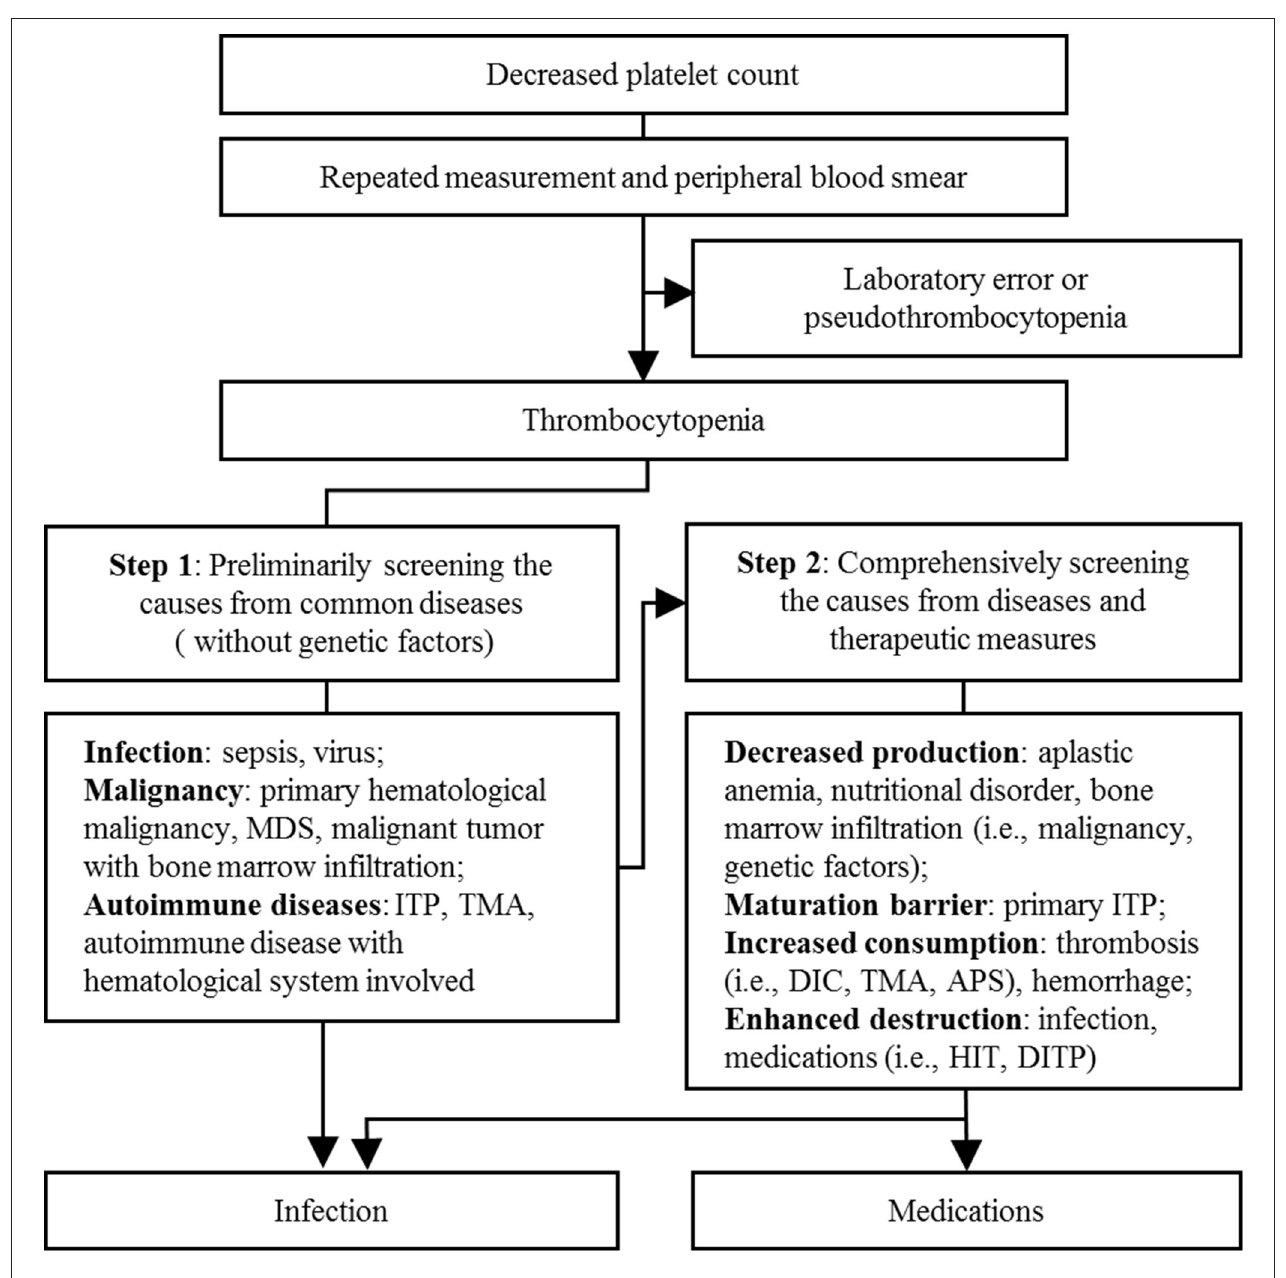
FIGURE 2 | Diagnostic reasoning in thrombocytopenia. APS, antiphospholipid syndrome; DIC, disseminated intravascular coagulation; DITP, drug-induced thrombocytopenia; ITP, immune thrombocytopenia; HIT, heparin-induced thrombocytopenia; MDS, myelodysplastic syndrome; TMA, thrombotic microangiopathy.